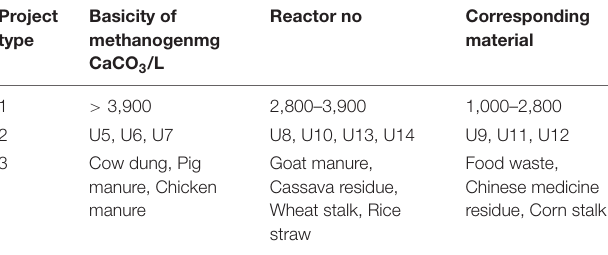
TABLE 4 | Average basicity of methane bacteria in fermentation tank at later stage of